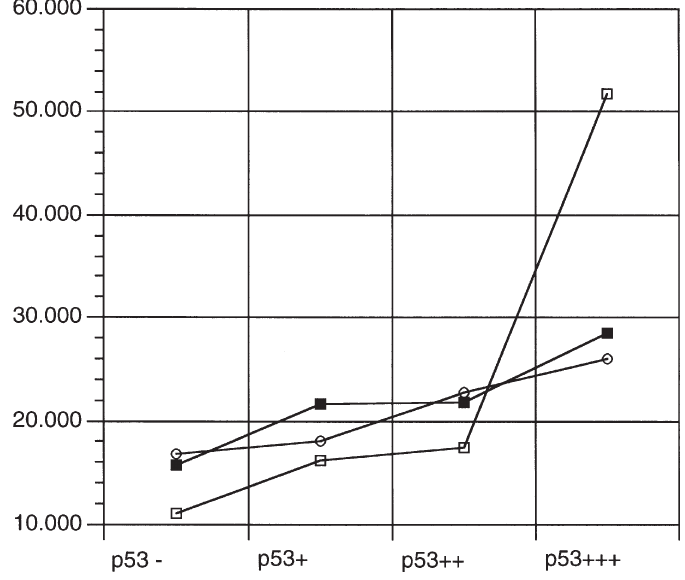
Fig. 4. Standard deviation of integrated optical density (S.D. IOD) in nuclear populations with different p53 expression in correlation to the Bloom–Richardson grading. p53 − . . . p53 negative nuclei; p53 + . . . weakly positive nuclei; p53 ++ . . . moderately positive nuclei; p53 +++ . . . strongly positive nuclei. 1 G1 ∗ ; 2 G2; ! G3. ∗ Excluded from statistical analysis, the number of cases was too small for statistical